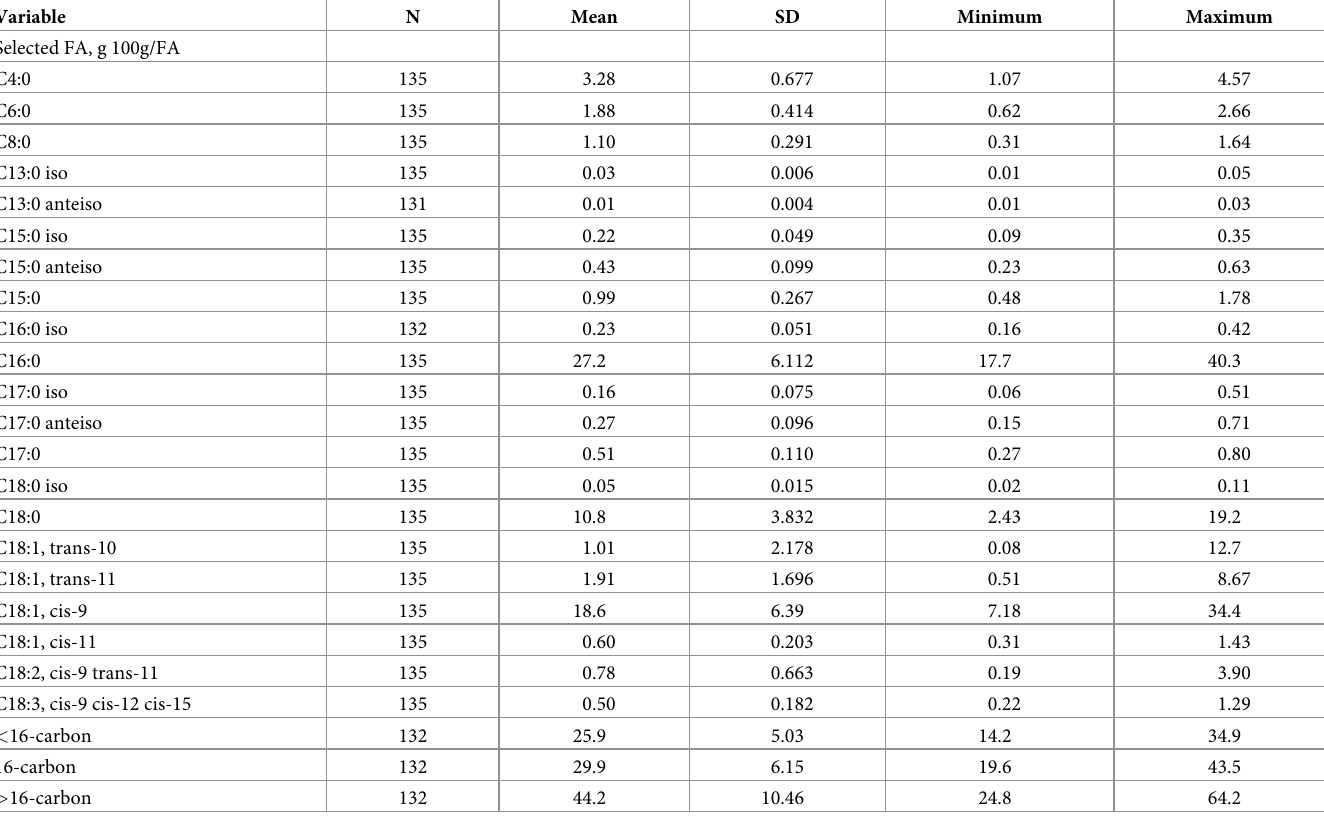
Table 3. Minimum, maximum, mean, and standard deviation values for selected milk fatty acids (FA) in the data